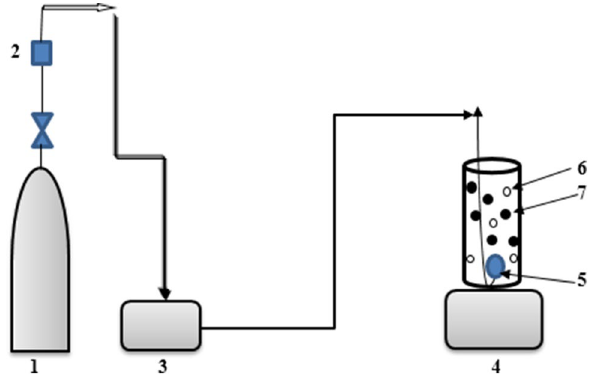
Fig. 2 Graphic diagram of the experimental set-up: (1) Oxygen